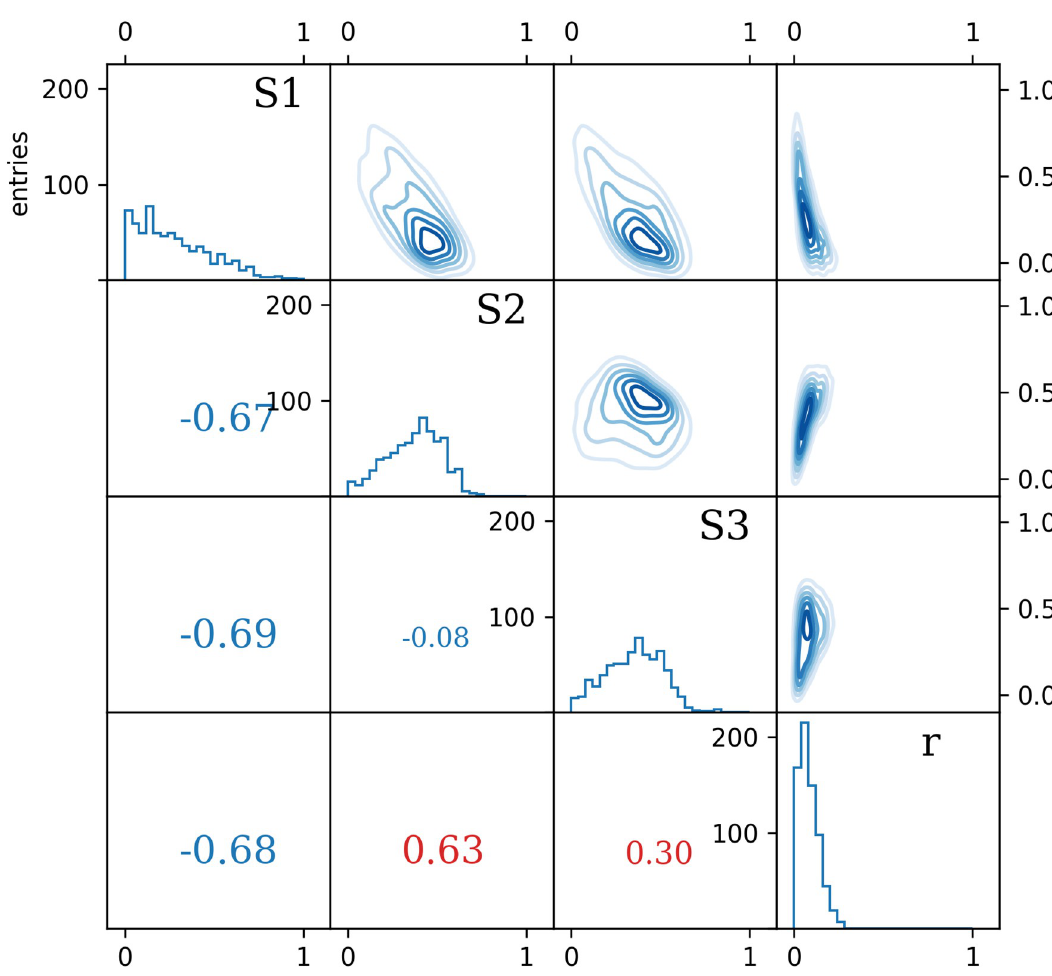
Fig 7. The MCMC algorithm evaluated probability distributions of 3 mixing fractions: f S 1 , f S 2 , f S 3 and fractionation parameter r describing the mixture (histograms on the diagonal) with cross-correlations (top-right) and calculated correlation coefficients (bottom-left). Positive correlation of source S 2 contribution and the progress of fractionation process r is due to opposite influence on the mixture (increasing f S 2 results with higher I 1 and I 2 values, while increasing r does the opposite due to negative value of the parameter A ). The non-linear shapes of the contour plots in the right-most column are due to logarithmic dependence on r (see Eq